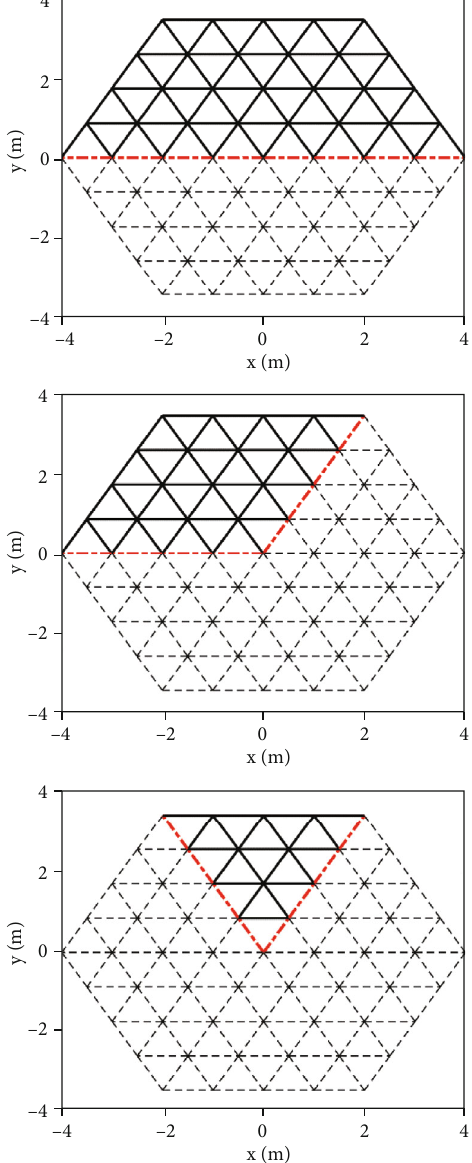
Figure 7: Characteristic structure of cable